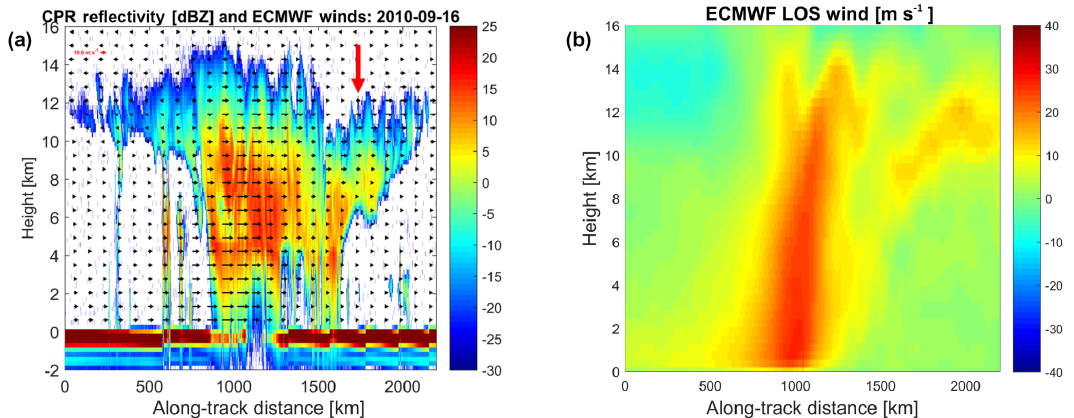
Figure 3. (a) CloudSat radar vertical reflectivity profile at W-band for overpass of Atlantic Hurricane Igor on 16 September 2010 between 17:13 and 17:28UTC (corresponding to along-track distance of 2200km). The ECMWF line-of-sight winds projected onto the CloudSat curtain are plotted as arrows. (b) Contour plot of ECMWF line-of-sight winds. The reflectivity data are provided at CloudSat resolution (1.1km horizontal, 0.5km vertical), whereas the ECMWF winds are at 0.1 ◦ resolution ( ∼ 10km). For presentation purposes, only winds every 10km along the curtain and every 700m in the vertical are shown (a) .